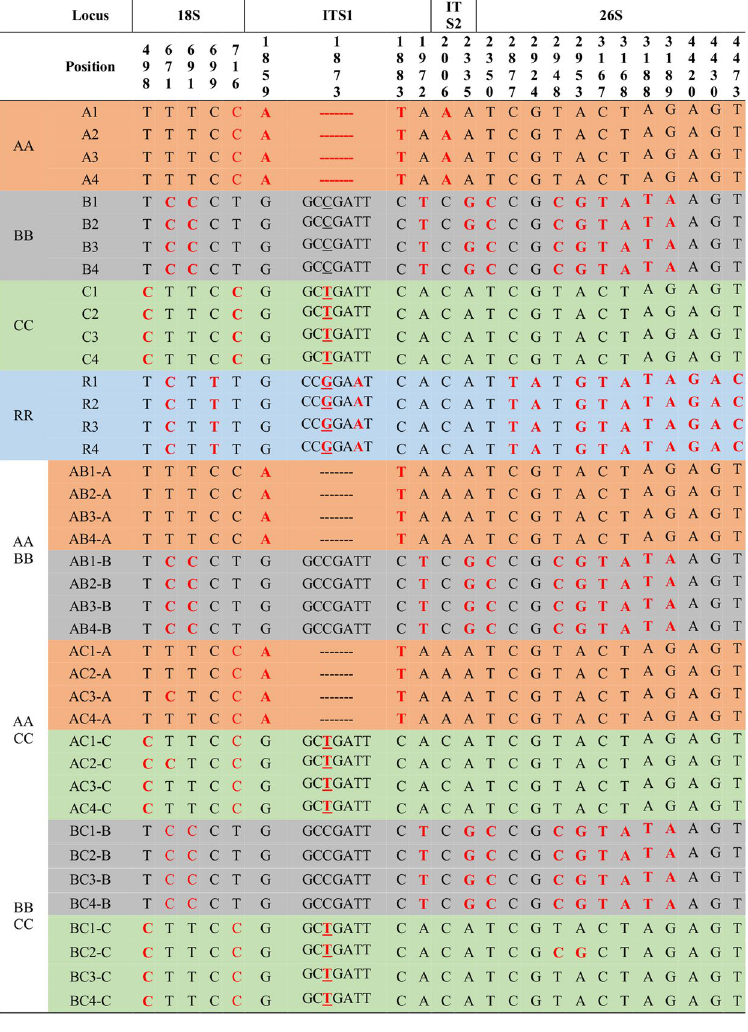
Figure 3. Summary of nucleotide variations based on 45SnrDNA sequences from 28